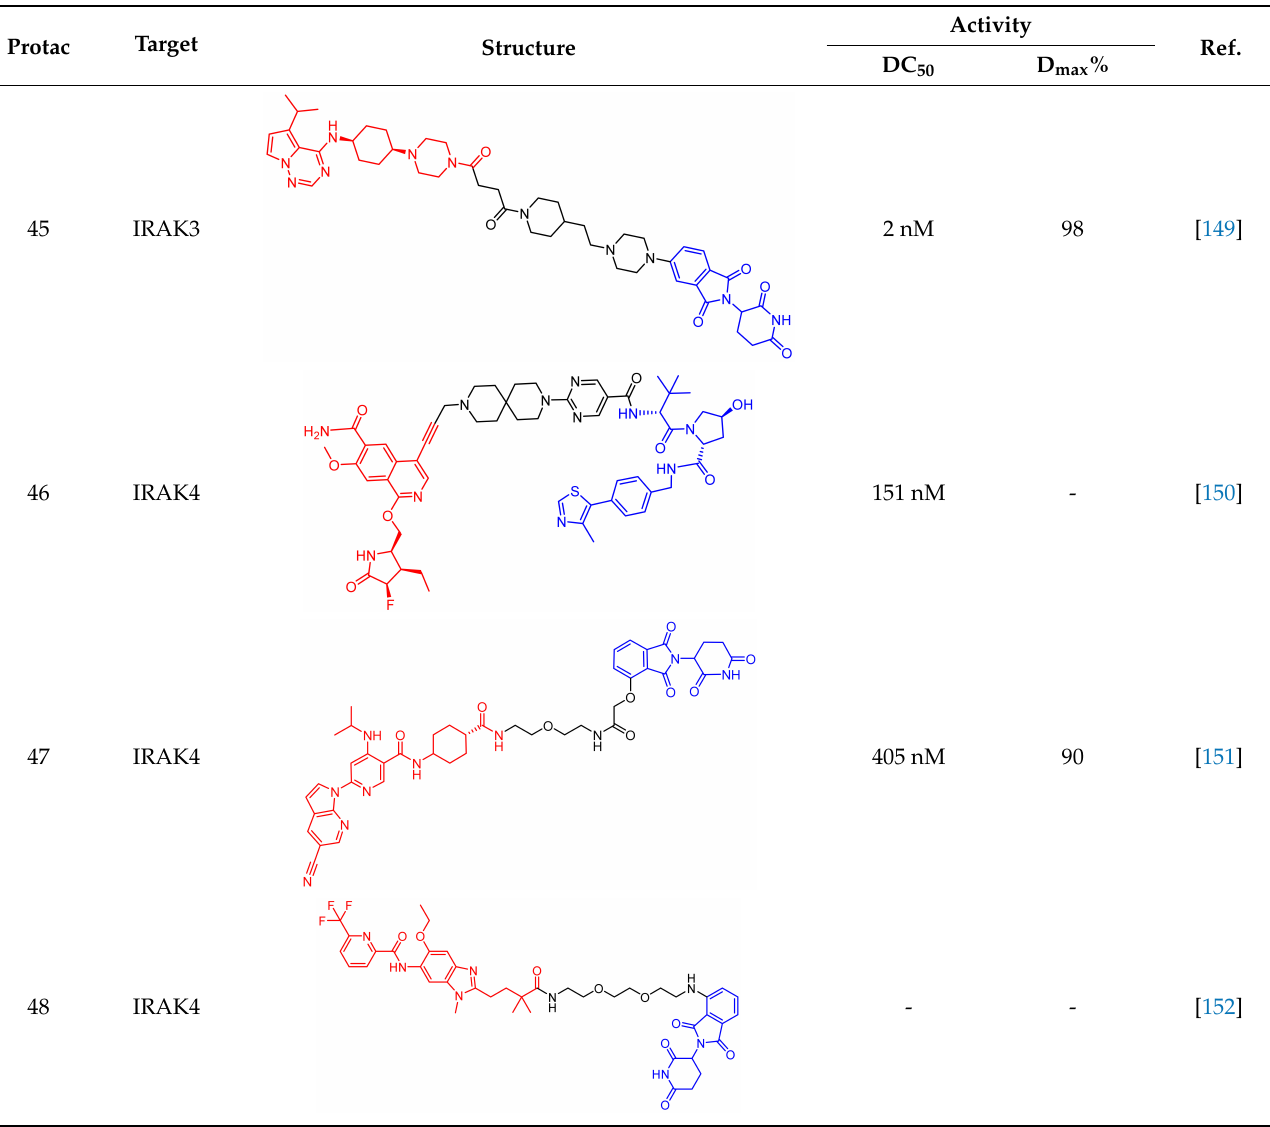
Table 2. Representative PROTACs for immune